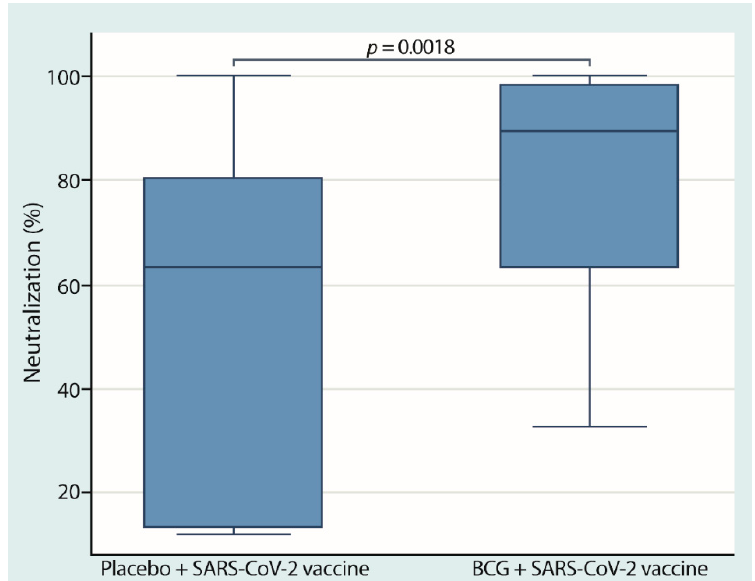
Figure 3. Neutralizing antibody induction is higher in individuals previously revaccinated with BCG. Blood was drawn thirty days after step three, and the levels of neutralizing antibodies against SARS-CoV-2 were determined by immunoassays. Boxes represent the median ± IQR, whiskers extend to 95% confidence intervals, and individual dots represent outlier values. The lines show the p -values for comparison between groups. Table 3. Allele frequency among Placebo–anti-SARS-CoV-2 and BCG–anti-SARS-CoV-2 subjects.